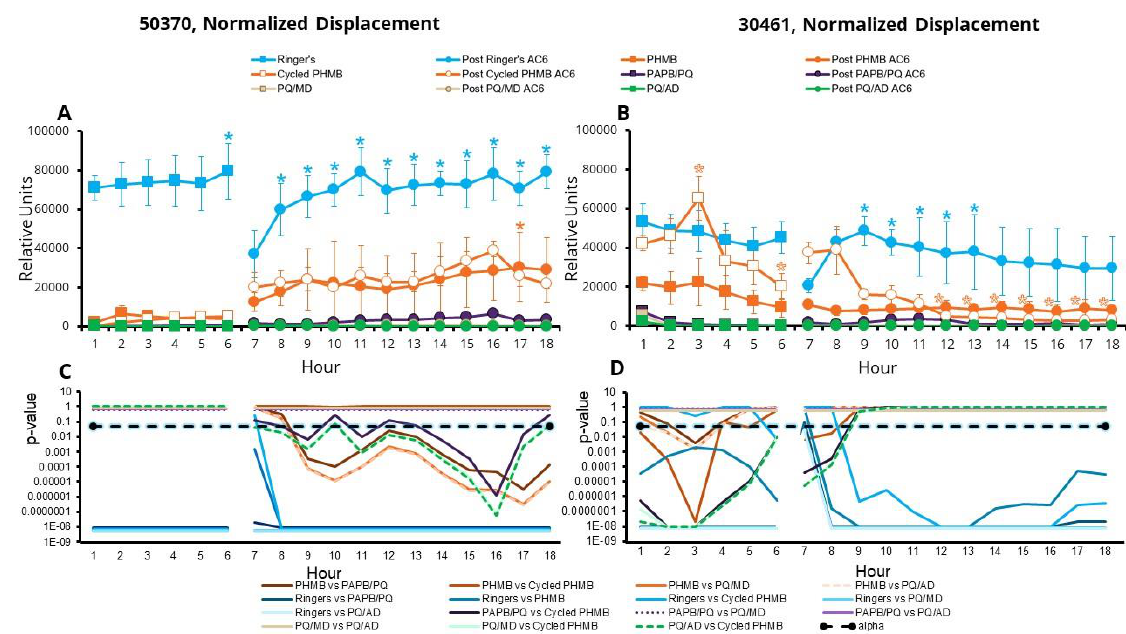
Figure 7. Surviving Acanthamoebae recover displacement after disinfection. Amoebae were disinfected or put in one-quarter Ringer’s solution for the first 6 h, followed by AC6 media for the following 12 h (total 18 h). Normalized displacement is presented as mean ± SE. ( A ) Acanthamoeba castellanii (ATCC 50370), and ( B) Acanthamoeba polyphaga (ATCC 30461). Relative units: average displacement of each amoeba in the field of view, multiplied by the number of moving amoebae, resulting in the total number of microns moved by all amoebae. * p < 0.05 vs. each condition’s own baseline (either hour 1 or hour 7 for CLC or AC6 conditions, respectively). Statistical comparisons between conditions are represented in ( C ) p -values for ( A ), and ( D ) p -values for ( B ). Alpha was set at 0.05. n = 3/group.